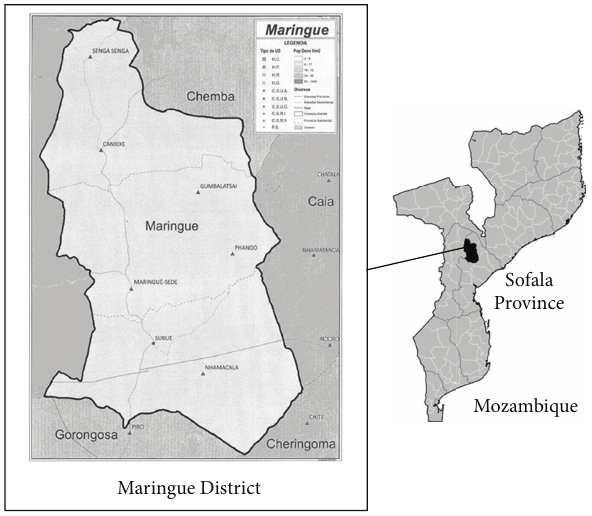
Figure1:MapoftheMaringueDistrictindicatingthelocationofthe seven health units (Unidade Sanitaria, US): Maringu´e-Sede, Canx- ixe, Gumbalatsai, Nhamacala, Phango, Senga-Senga, and